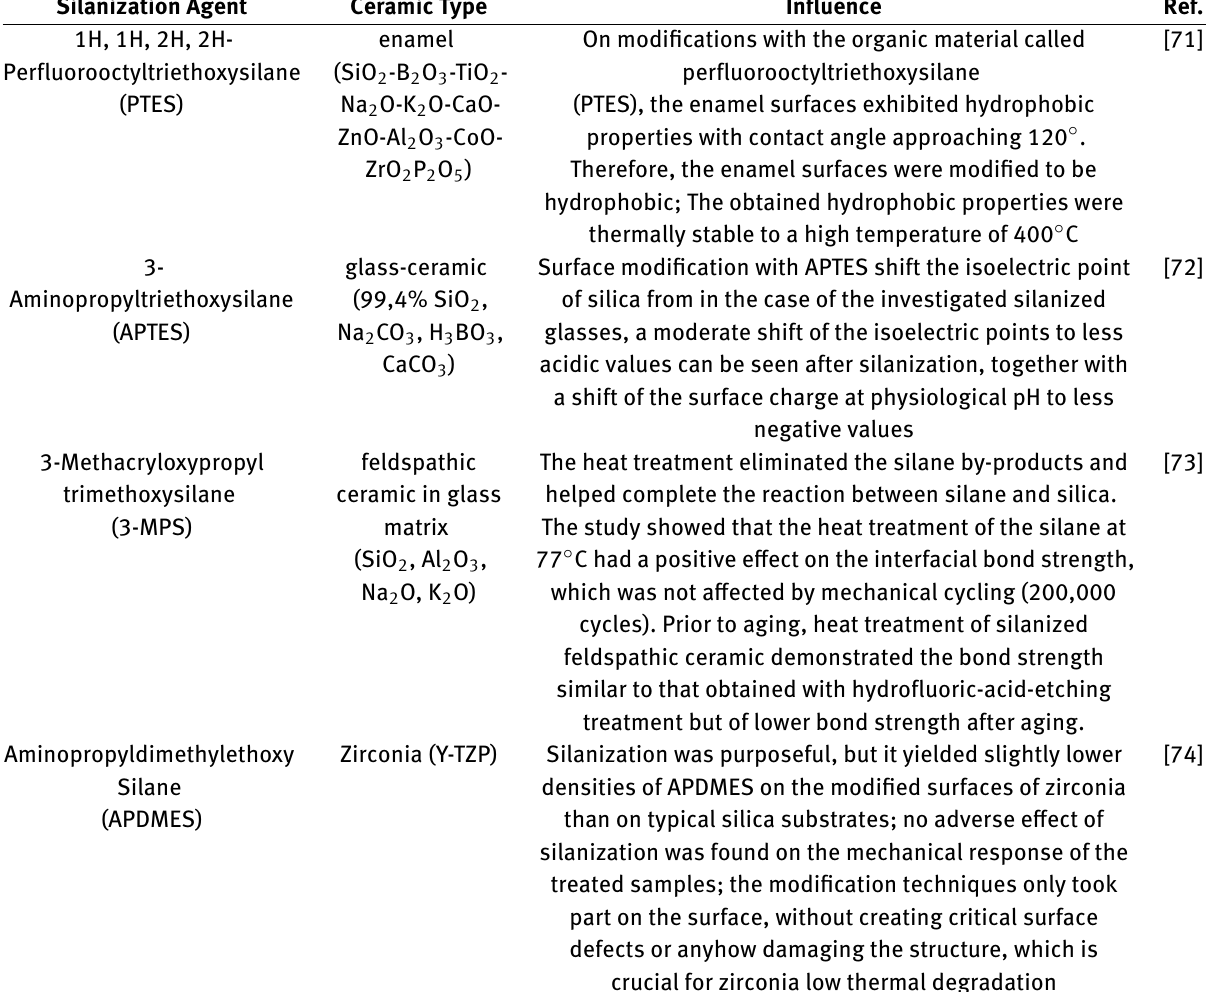
Table 6: Silanization process characteristics for various types of bioceramics Silanization Agent Ceramic Type Influence